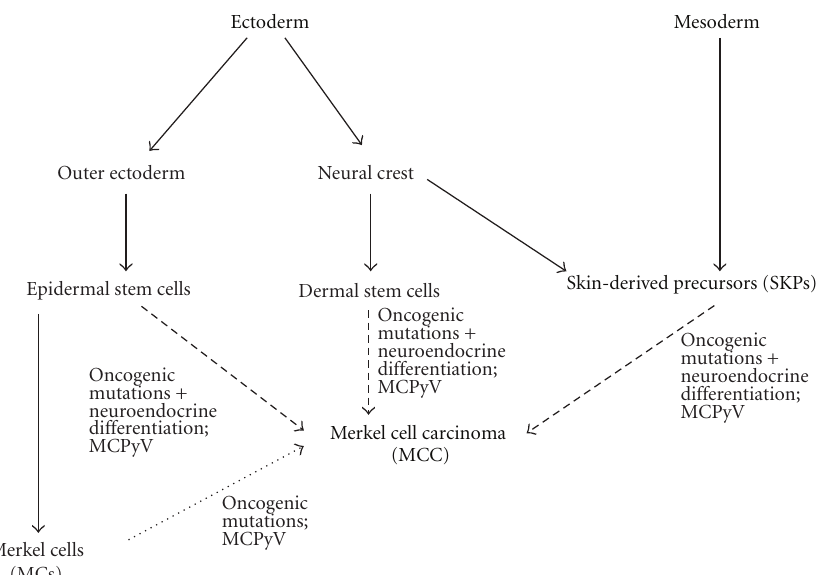
Figure 1: Scheme of potential cells of origin of Merkel cell carcinoma (MCC), shown from an ontogenetic perspective. All arrows with a scattered line represent thus far hypothetic lineage relationships. However, whereas MCC derivation from Merkel cells is not very likely, there are hints implying epidermal stem cells in MCC genesis, and dermal stem cells as well as SKPs at least cannot be excluded as cells of origin for MCC. For each putative cell type of origin, an involvement of MCPyV in MCC genesis is highly probable, at least in a large fraction of